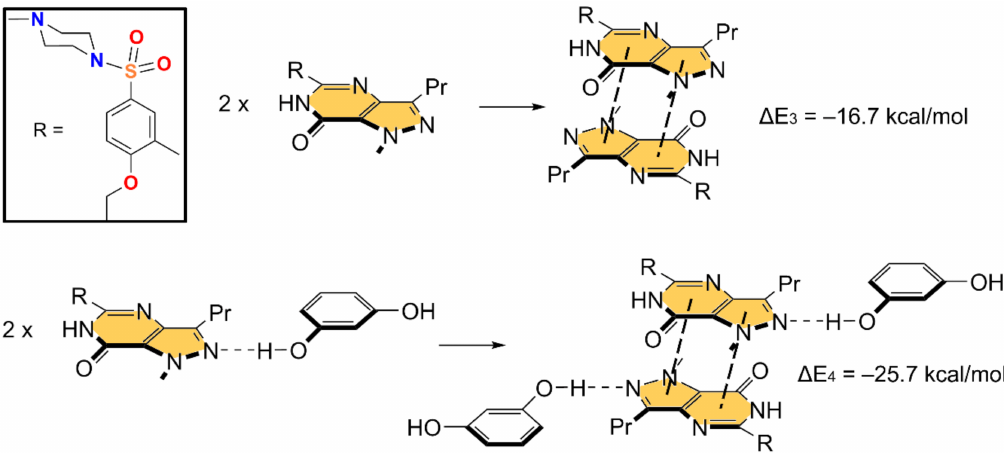
Figure 5. Reactions employed to measure the H-bonds in the dimer ( top ) and tetramer ( bottom ).